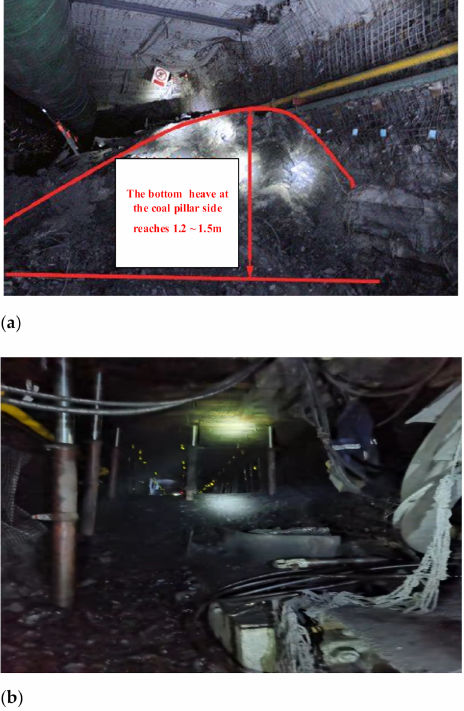
Figure 2. Roadway deformation diagram:( a ) Floor heave, ( b ) Smaller roadway section.